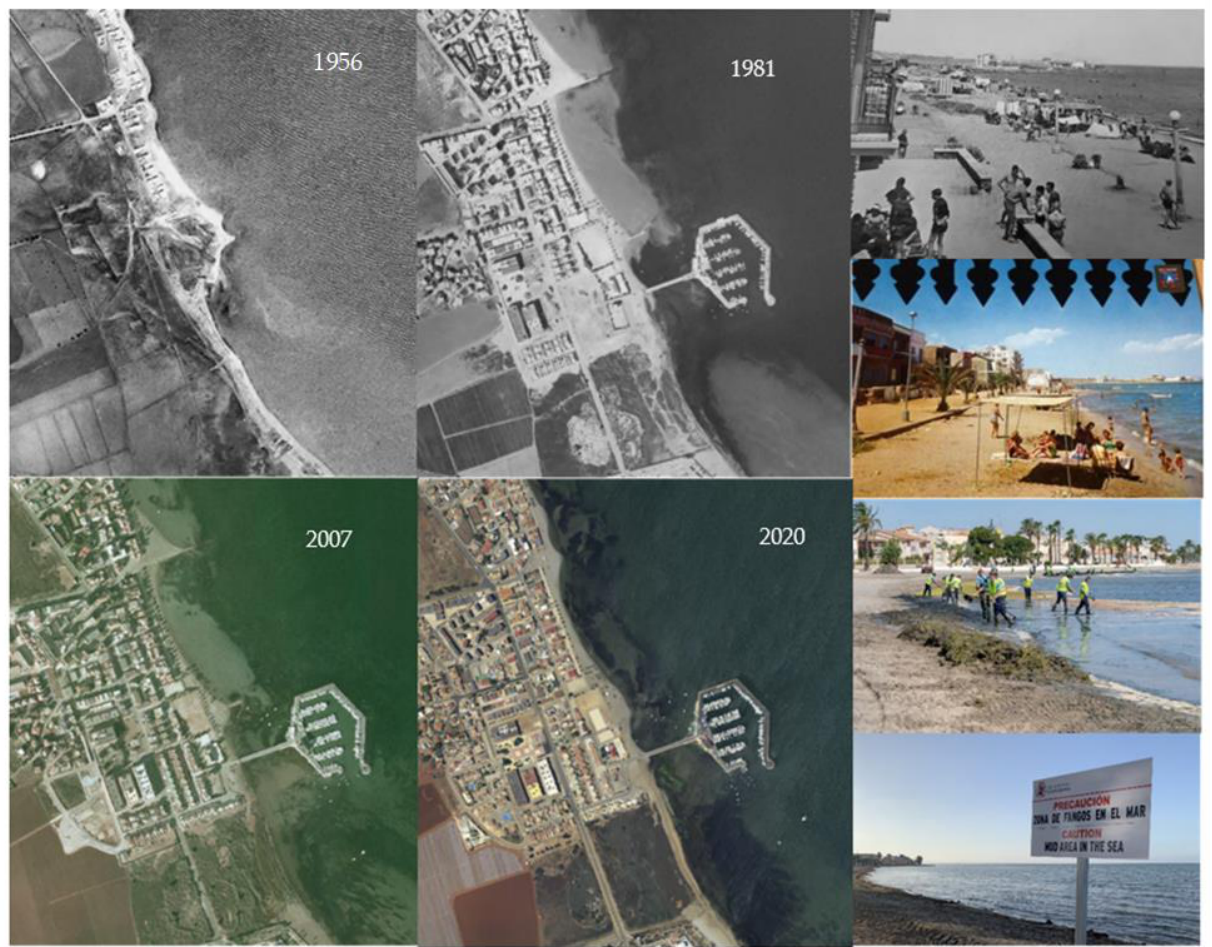
Figure 9. Los Urrutias island harbor’s evolution from 1956 to 2020. Source: Sistema de Informaci ó n Territorial de la Regi ó n de Murcia and data from